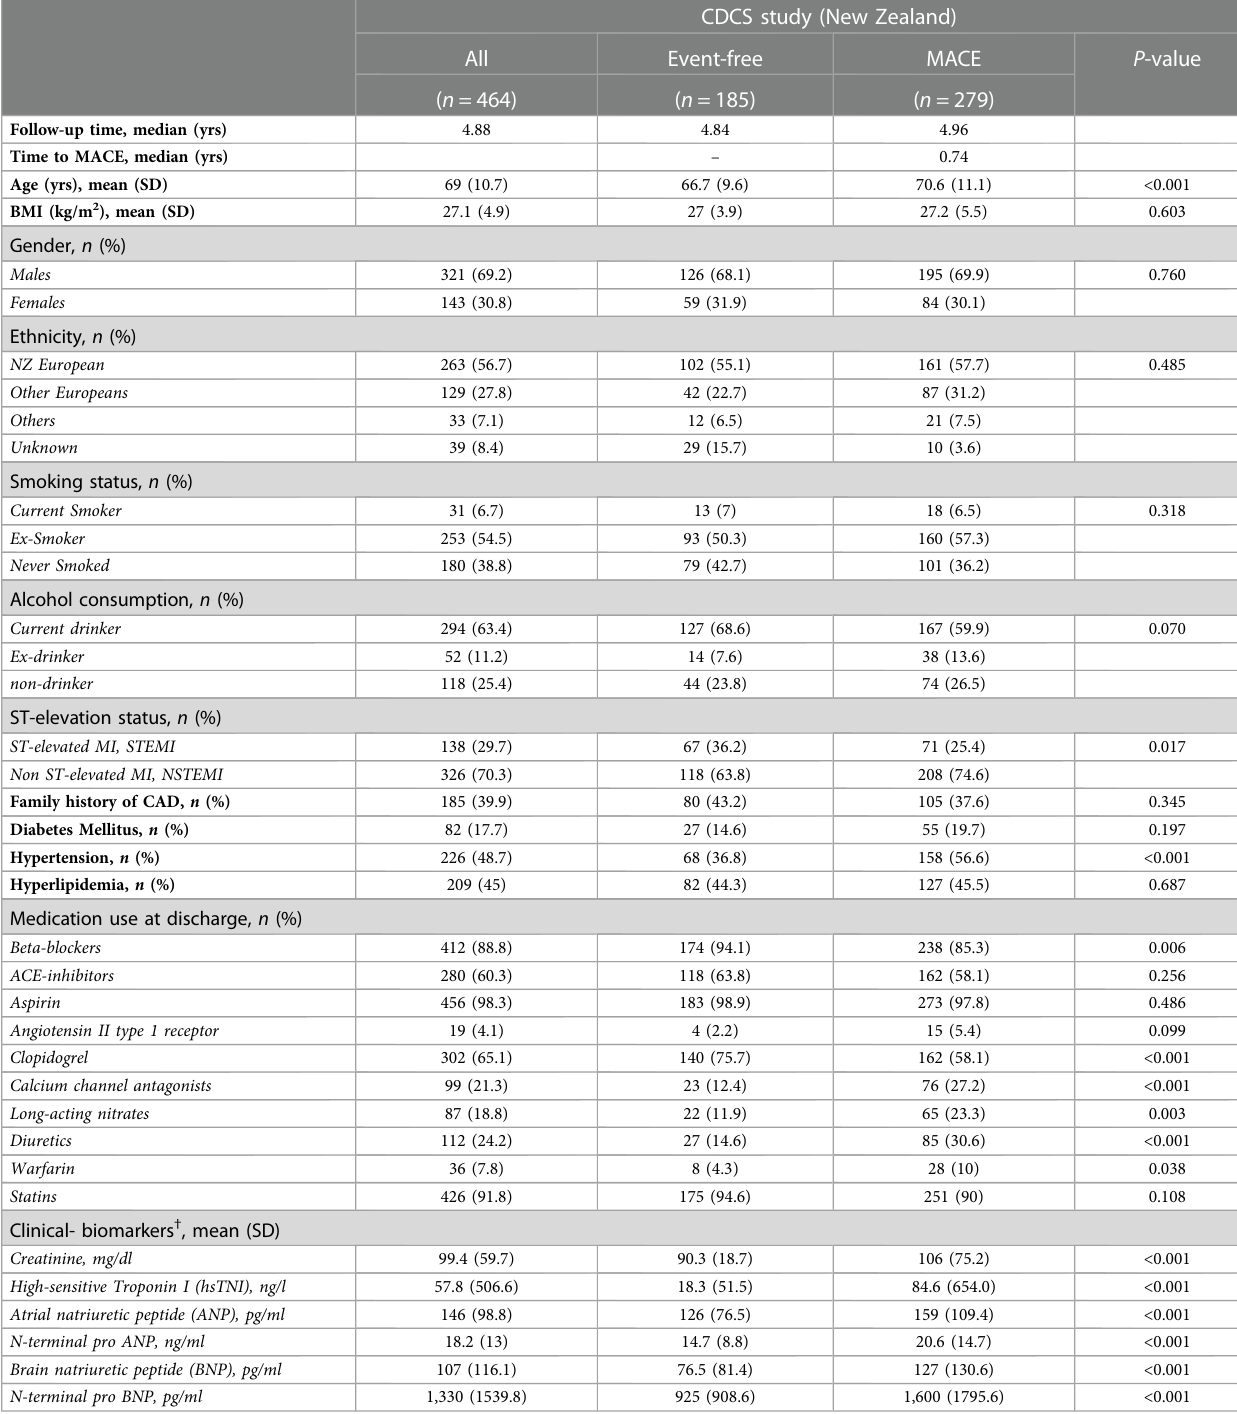
TABLE 1 Clinical characteristics of post-AMI patients in CDCS